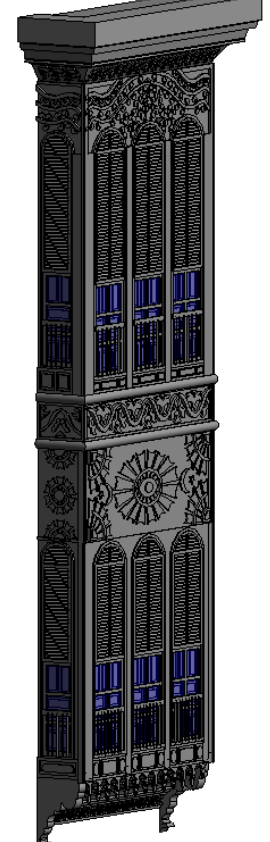
Figure 11. The final result of the 3-D modelling Point into